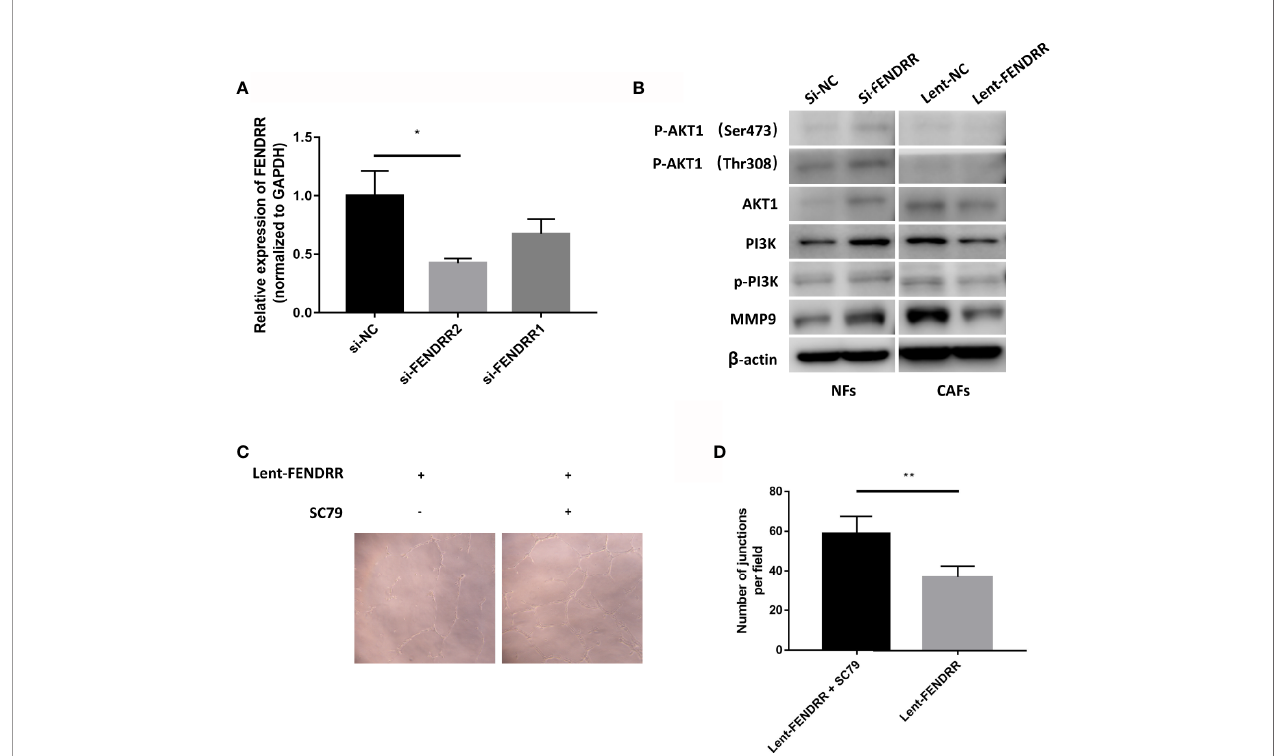
FIGURE 5 | FENDRR inhibits the activation of the PI3K/AKT pathway. (A) The silencing effect of siRNAs. (B) Western blotting analyses of PI3K/AKT pathway-related genes showed that the knockdown of FENDRR activated the PI3K/AKT pathway in NFs, while the overexpression of FENDRR weakened the activation of the PI3K/AKT pathway in CAFs. (C, D) The number of the capillary-like structure formed by HUVECs co-cultured with SC79-treated CAFs transfected with Lent-FENDRR increased signi fi cantly. * P < 0.05, ** P <